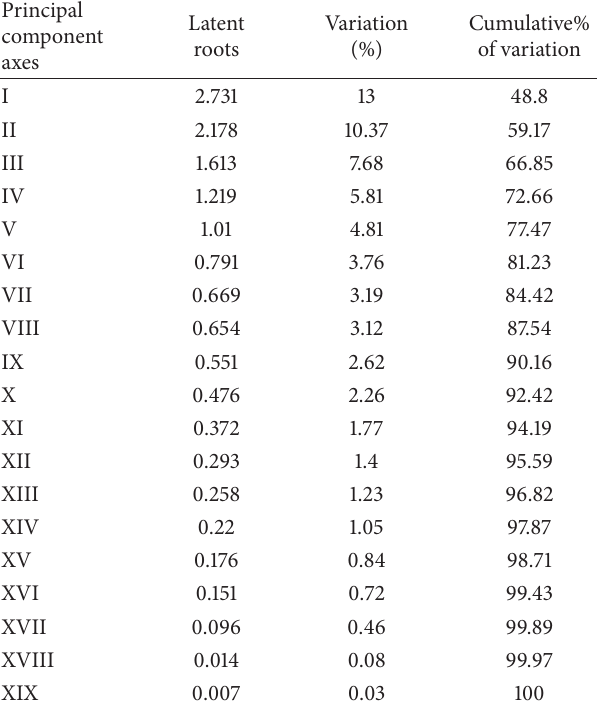
Table 7: Latent roots (eigen values) and their variation in 19 quantitative characters in 113 aromatic and fine rice